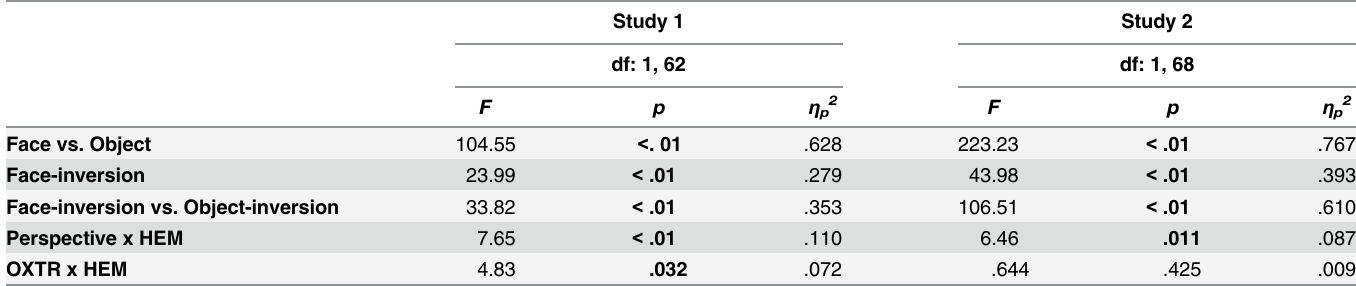
Table 2. Results of ANOVAs with repeated measurements regarding N170-amplitudes in reaction to upright and inverted neutral faces, and objects (chairs); Hemisphere (HEM), perspective (upright vs. inverted picture), Oxytocin-receptor-gene-polymorphism rs53576 (OXTR).